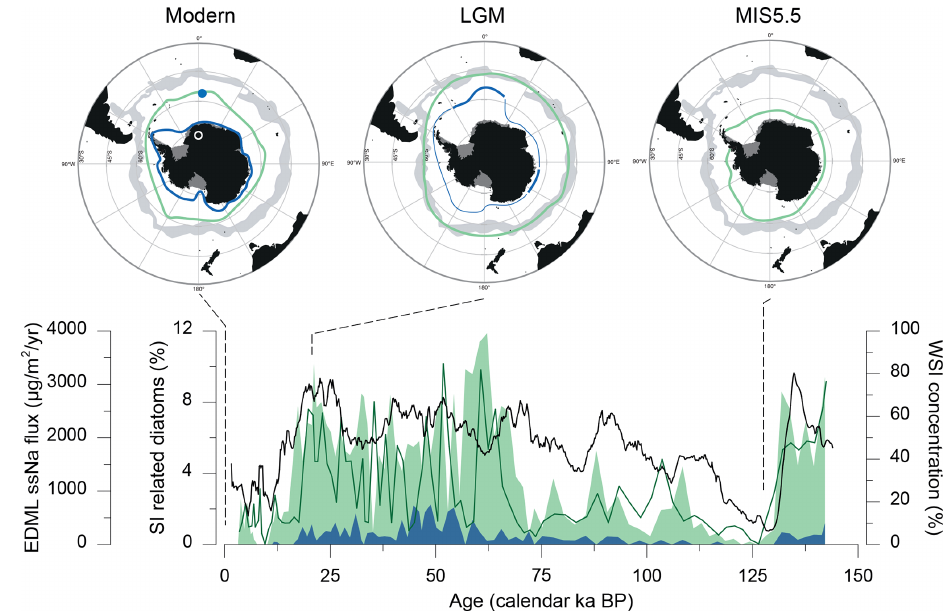
Figure 4. Sea-ice reconstructions over the last glacial-interglacial period. Lower plot: ssNa flux in the EPICA Dronning Maud Land (EDML) ice core (black line) (Fischer et al., 2007, here smoothed with a 200-year running mean and plotted on the AICC2012 timescale, Veres et al., 2013). Relative abundance of sea-ice (SI) related diatoms and winter sea-ice (WSI) concentration estimates. The F. curta group (green shading) is a proxy for WSI presence while F. obliquecostata (blue shading) is a proxy for summer sea-ice (SSI) presence. WSI concentration estimates (green line) are based on the application of the MAT to diatom assemblages in marine sediment core PS1768-8 (Gersonde and Zielinski, 2000). Upper plot: maps of winter (green line) and summer (blue line) sea-ice edges in the modern (Hobbs et al., 2016), the Last Glacial Maximum (LGM at 19–23ka BP; Gersonde et al., 2005) and the warmer-than-pre-industrial MIS5.5 (125–130ka BP; Holloway et al., 2017). Grey field represents the modern polar front zone (Orsi et al., 1995). For the LGM map, the thick blue line indicates regions where marine data suggest the presence of SSI while the thin blue line indicates regions where SSI is inferred to be south of core sites in which SSI was not identified, and applying the modern relationship between SSI and SST to LGM SSTs (Lhardy et al., 2021). Location of marine sediment core PS1768-8 shown as a blue dot and EDML ice core shown as a white circle on the modern